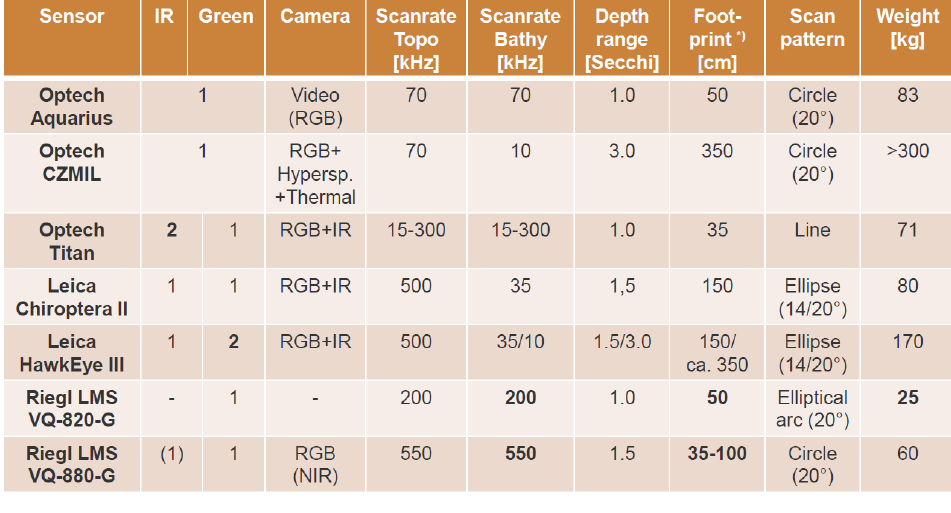
Table 1. Compilation of recent ALB scanning systems (© Gottfried Mandlburger).